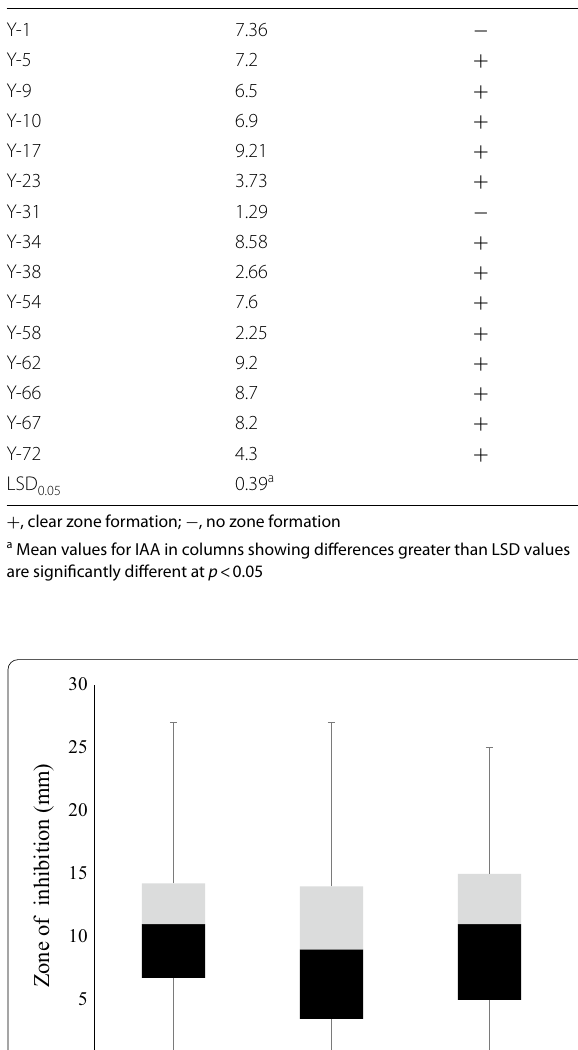
Table 1 Production of indole acetic acid (IAA) and phosphate solubilization by some potential endophytic yeast isolates in vitro